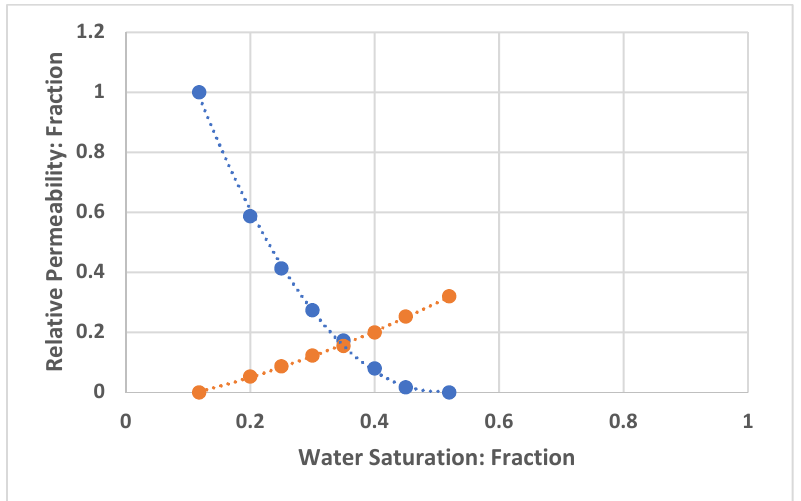
Figure 12. Average water–oil relative permeability versus water saturation for Shueib formation.